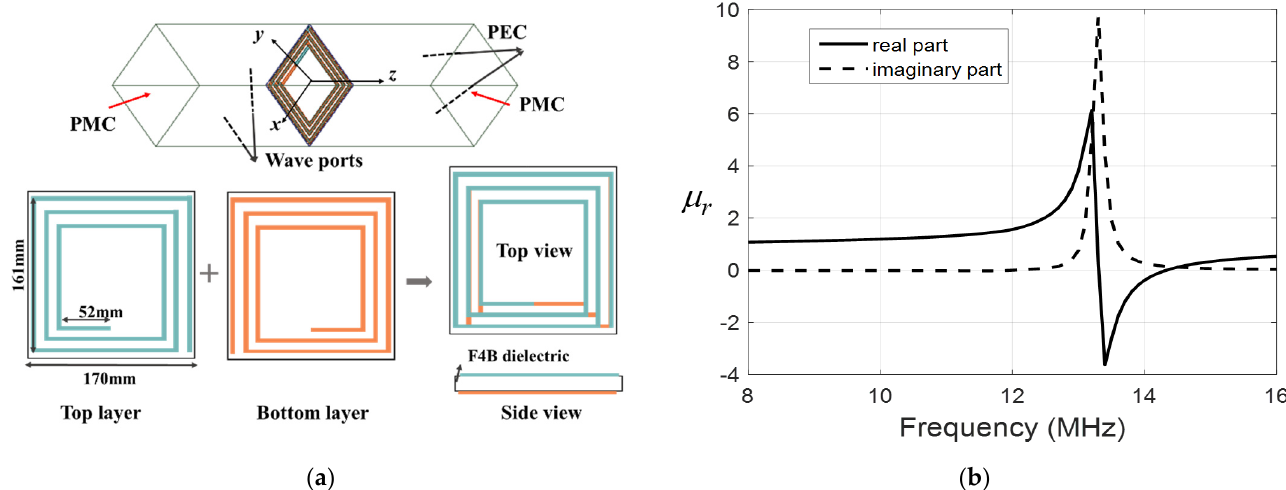
Figure 3. ( a ) The geometry of double − side three − turn spiral metasurface cell and periodic boundary simulation model. ( b ) The retrieval of real and imaginary parts of relative permeability of the metasurface cell.